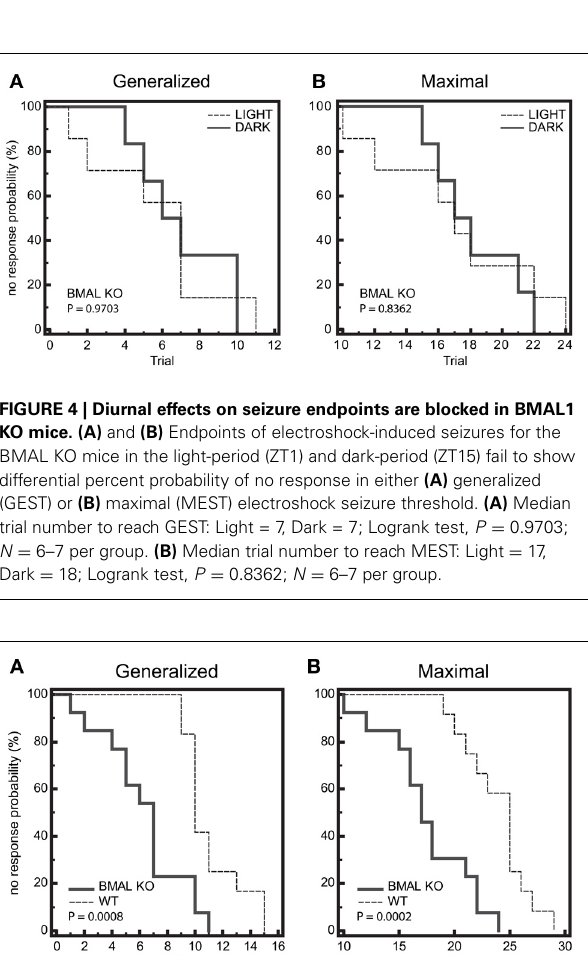
FIGURE 5 | Seizure endpoints are reduced in BMAL1 KO mice compared to WT. (A) and (B) Endpoints of electroshock-induced seizures comparing BMAL KO mice and WT mice from data combined in for the light-period and dark-period (ZT1 and ZT15) show differential percent probability of no response in both (A) generalized (GEST) and (B) maximal (MEST) electroshock seizure threshold. (A) Median trial number to reach GEST: WT = 10, BMAL KO = 7; Logrank test, P = 0 . 0008; N = 12–13 per group. (B) Median trial number to reach MEST: WT = 25, BMAL KO = 18; Logrank test, P = 0 . 0002; N = 12–13 per